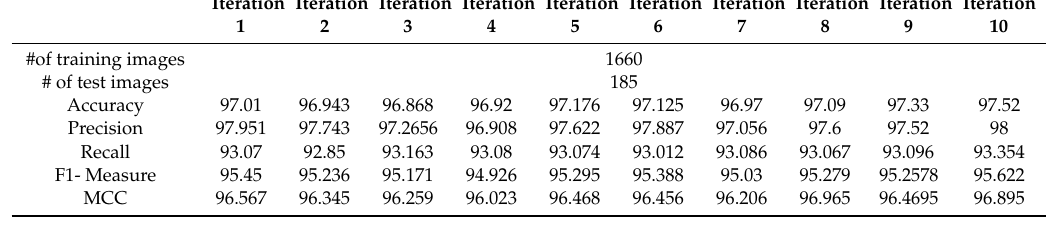
Figure 10. The 10-fold cross-validation average result on CASIA V2.0 using the proposed model. Table 5. The detailed results of 10-fold cross-validation on DVMM using the proposed model.